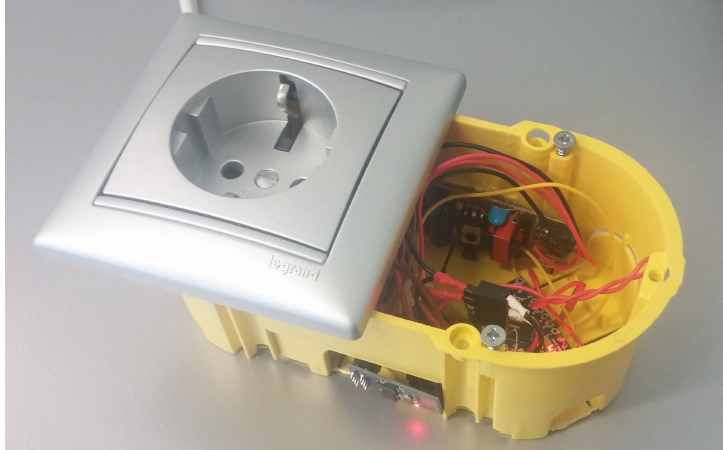
Figure 10. Light dimming ITN integrated into a wall power socket